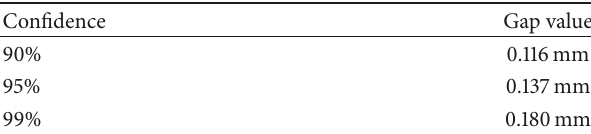
Table 6: Interval confidence